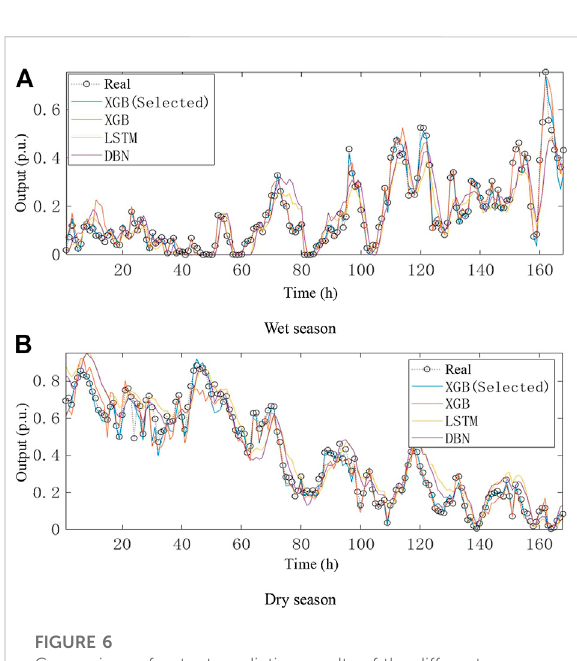
FIGURE 6 Comparison of output prediction results of the different algorithms. (A) Wet season. (B) Dry